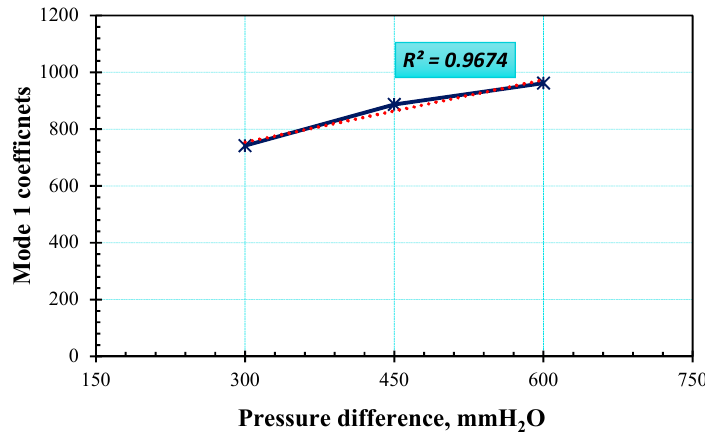
Figure 20. Linear fit between average absolute values of mode 1 coefficients and various pressure differences.